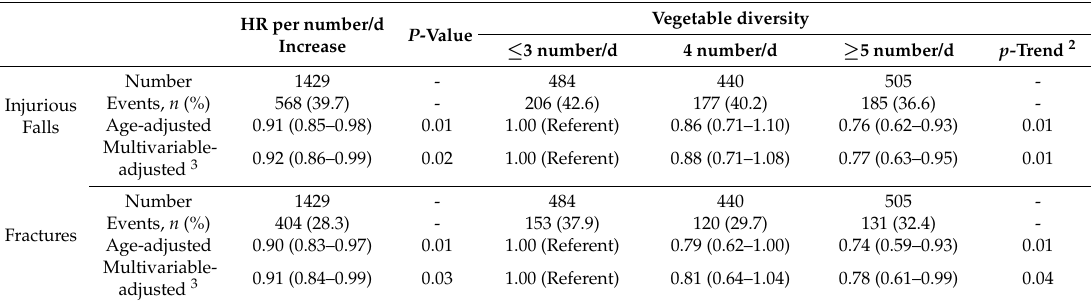
Table 2. Hazard ratios (HR) for injurious falls and fractures over 14.5 years by daily vegetable diversity intake categories 1 .